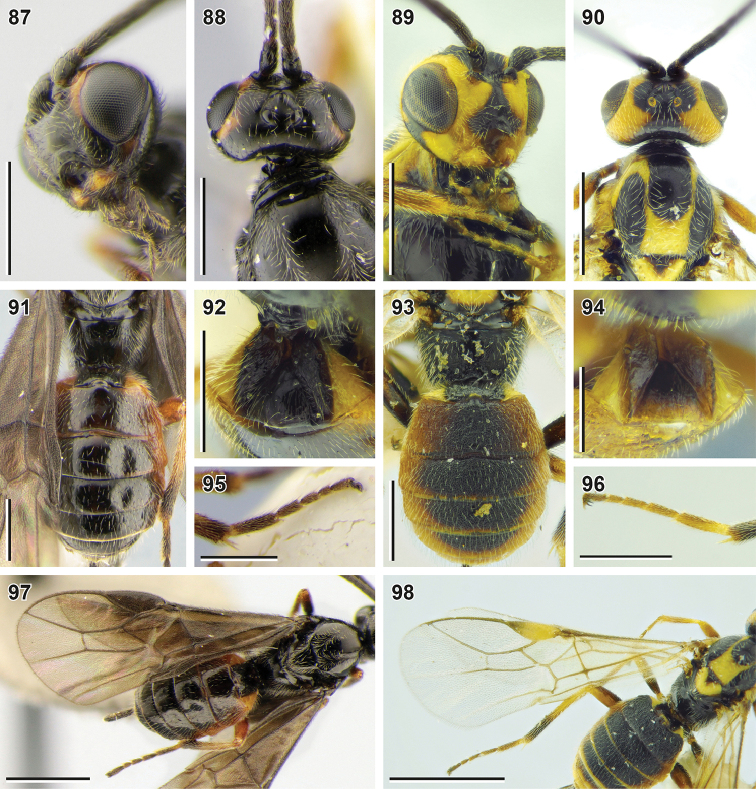
Bracon
kasparyani Samartsev, 2018 (87, 91, 97 holotype, ZISP88, 92, 95 female paratype, ZISP), Bracon
variegator Spinola, 1808 (89, 90, 93, 94, 96, 98 female, ZISP) 87, 89 head, ventrolateral view 88, 90 head and mesoscutum, dorsal view 91, 93 metasoma, dorsal view 92, 94 first metasomal tergite, dorsal view 95, 96 hind tarsus 97, 98 fore wing. Scale bars: 1 mm (97, 98); 0.5 mm (87–93, 95, 96); 0.25 mm (87–93, 95, 96).